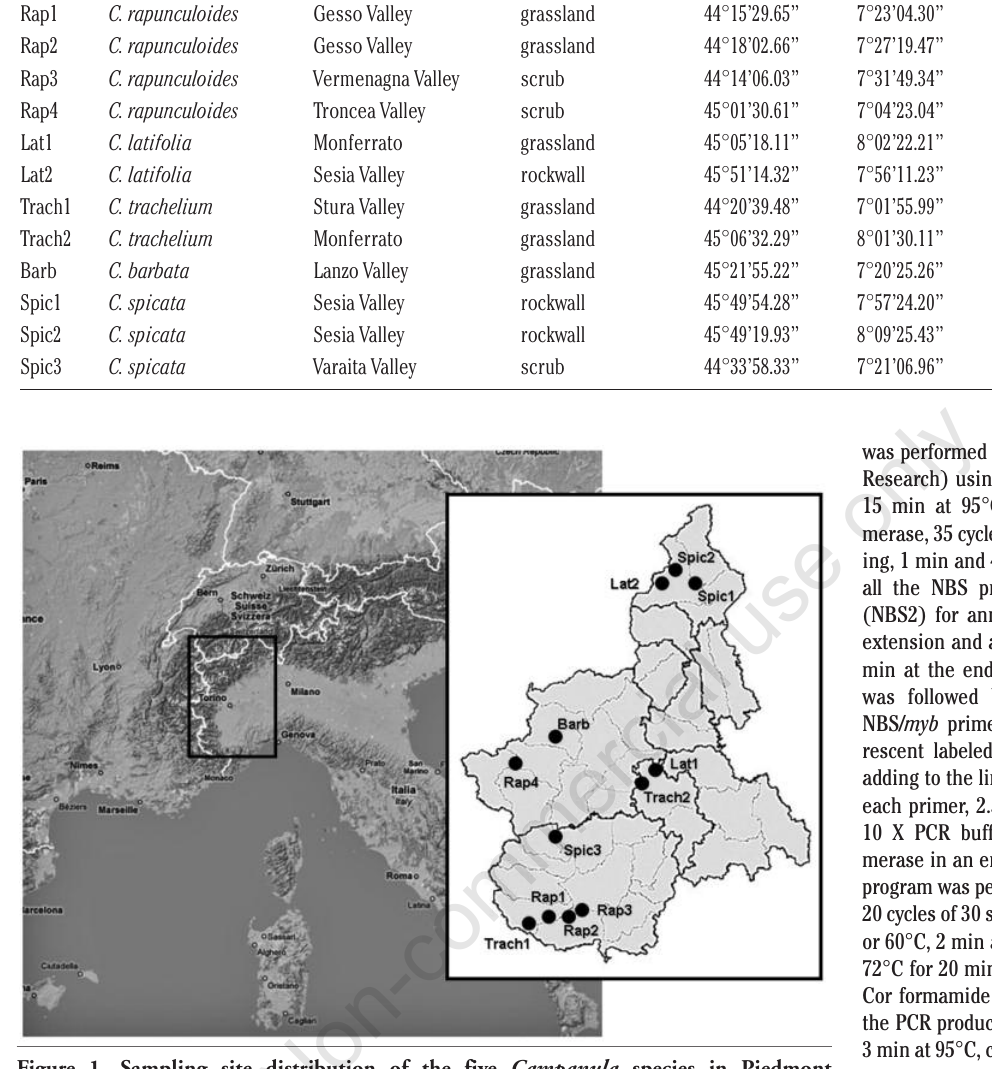
Figure 1. Sampling site distribution of the five Campanula species in Piedmont (Northern